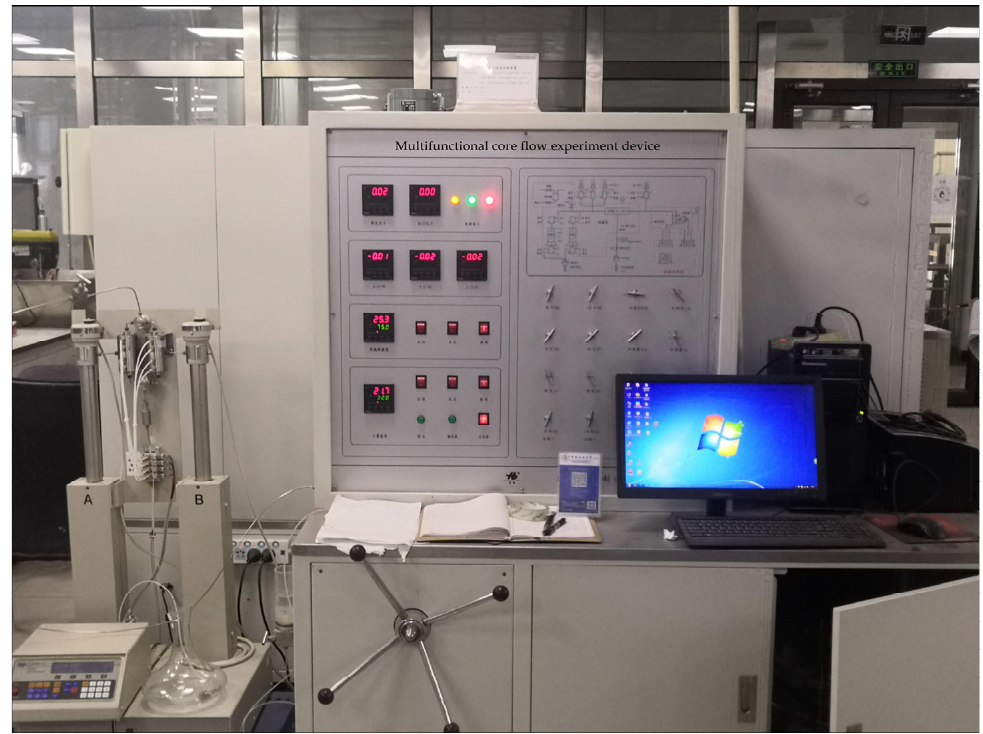
Figure 2. The photograph of the experimental setup of physical simulation of oil migration and accumulation. The experimental parameters were set according to the actual geological